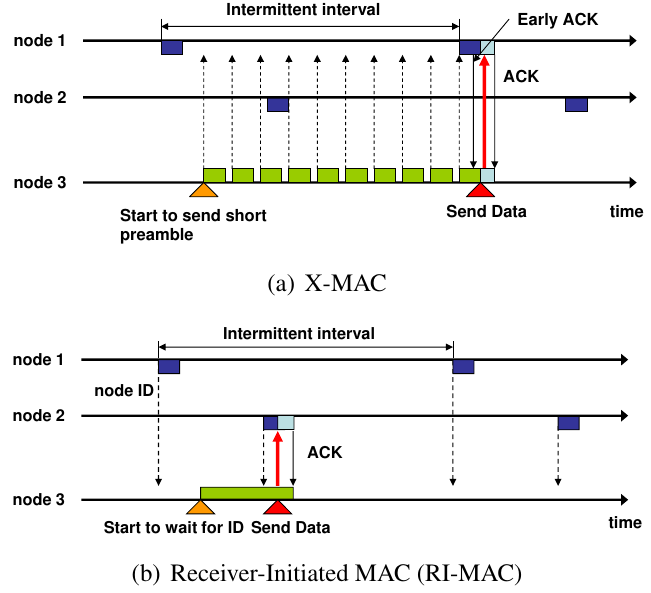
Figure 2. Other intermittent transmission